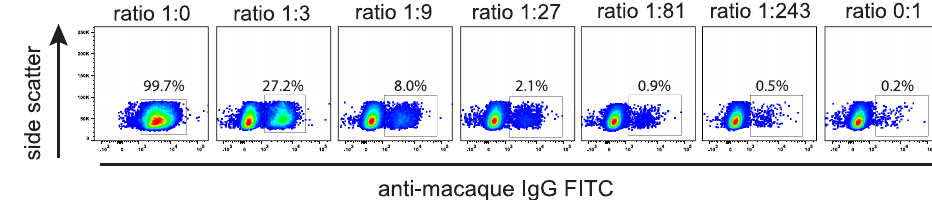
Fig 6. Detection of rare Mamu-A1 * 001-positive cells among predominantly Mamu-A1 * 001-negative cells. Mixtures of serial 1:3 dilutionsof Mamu-A1 * 001-positive PBMC to Mamu-A1 * 001-negative PBMC were exposedto P12 and detected with FITC-labeled anti-HA antibodyby means of flow cytometry. The percentages representthe frequenciesof Mamu-A1 * 001-positivelymphocytes detected in each